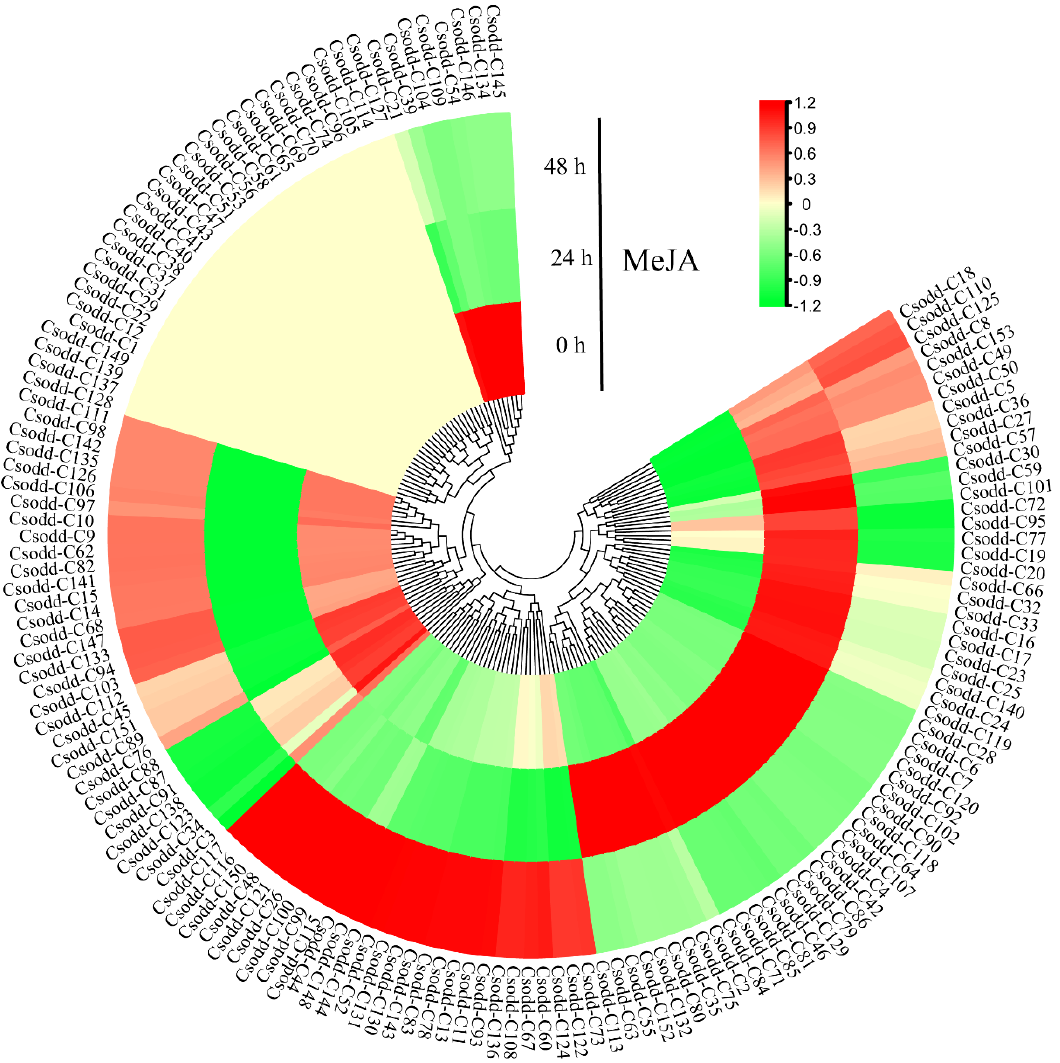
Figure 6. Gene−expression pattern of Cs2ODD−C genes in C. sinensis after MeJA treatment by RNA−seq. The scale bars represent the log2 transformations of the FPKM values. The colors from red to green indicate the highest-to-lowest log2 (FPKM) values of each gene under the MeJA treatment.